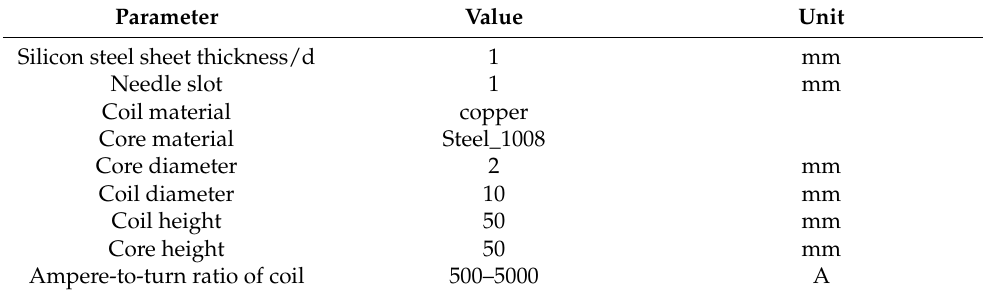
Table 2. Parameter table of electromagnetic coil .